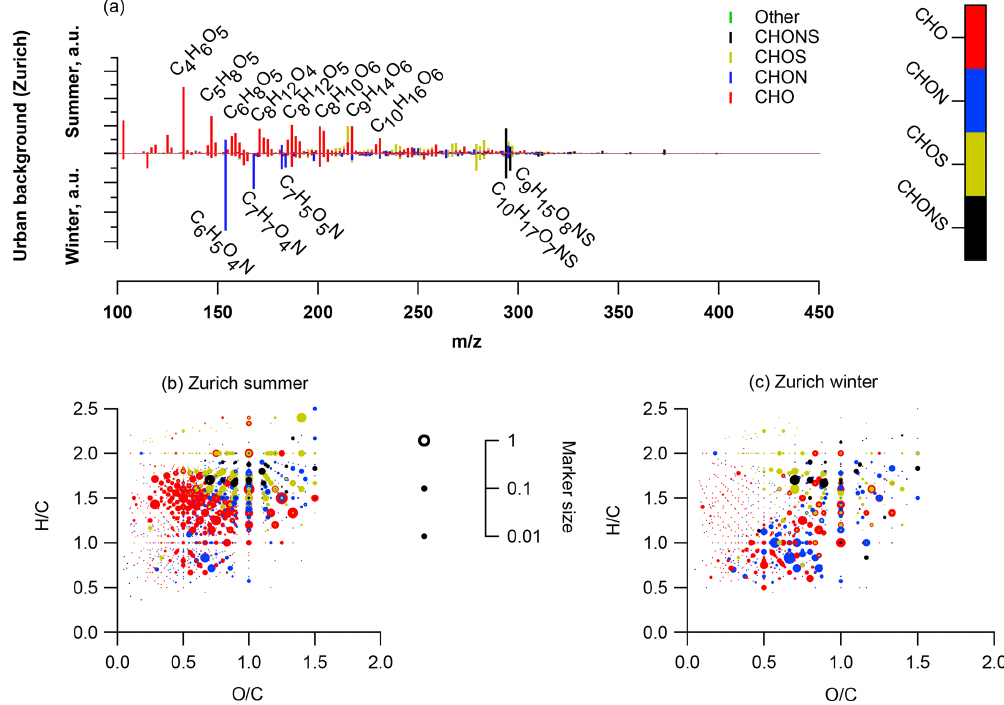
Figure 2. (a) Average summer ( T >11 ◦ C, mass-weighted OA, nine samples) and winter ( T <6 ◦ C, mass-weighted OA, six samples) ultra- high-resolution mass spectra integrated into unit-mass resolution in the negative mode for the organic aerosol in PM 10 sampled in Zurich during the year 2013 (weighed average with OA concentration from offline AMS analysis). The signal at a nominal mass is separated by ion family (CHO, CHON, CHOS, CHONS, or other). Peak assignments of dominant ions of selected unit mass resolution (UMR) peaks are labelled as neutral compounds. In the absence of a signal, the mass spectra are only plotted until m/z 450 instead of 650. (b) Van Krevelen diagrams (neutral composition) of average summer ( T >11 ◦ C, mass-weighted OA, nine samples) and winter ( T <6 ◦ C, mass-weighted OA, six samples) ultra-high-resolution mass spectra in the negative mode for the organic aerosol in PM 10 sampled in Zurich during the year 2013 (weighed average with OA concentration from offline AMS analysis). Peaks are displayed as circles with their size reflecting log(intensity) and colour code reflecting the molecular composition of the